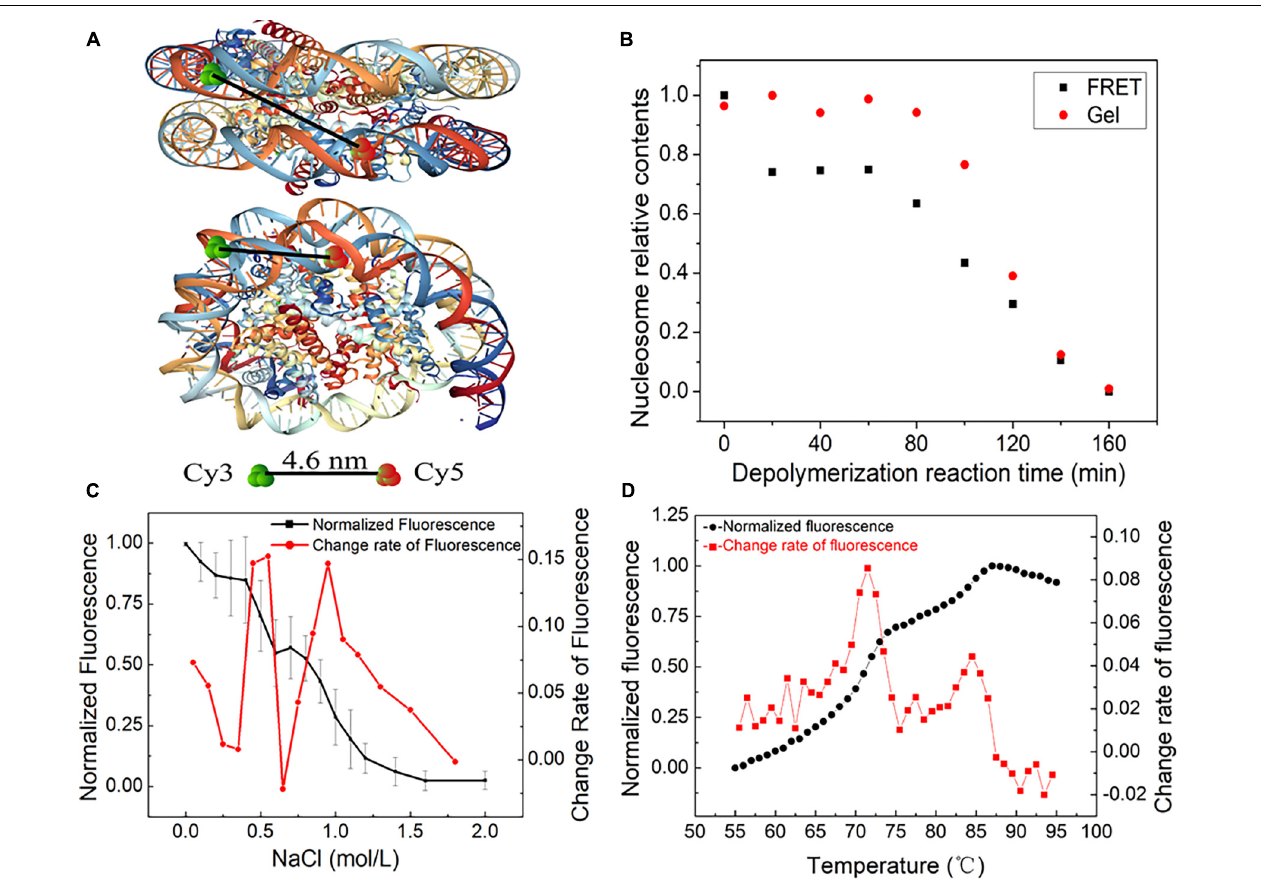
FIGURE 4 | The dynamic stages of nucleosome disassembly in vitro using the Widom 601 sequence. (A) Top and side views of the nucleosome with the position of donor Cy3 and acceptor Cy5 (structural outline of nucleosome: PDB ID 3 L Z1). (B) Nucleosome disassembly after incubation at 70 ◦ C. Red dots denote the amount of nucleosome DNA in total DNA detected by native PAGE, and black dots denote the relative signals of Förster resonance energy transfer (FRET) generated in nucleosomes. (C) FRET analysis of NaCl-dependent dissociation of nucleosomes. The black dots denote the normalized FRET signals obtained by monitoring the fluorescence difference between the donor and acceptor emissions upon donor excitation at 480 nm. The red dots are the change rate of FRET signals to NaCl concentration. (D) Thermal shift assays with the nucleosome using SYPRO Orange. The relative fluorescence intensity at each temperature is plotted as a black dot. The red dots show the differential values of the thermal stability curves presented in the black